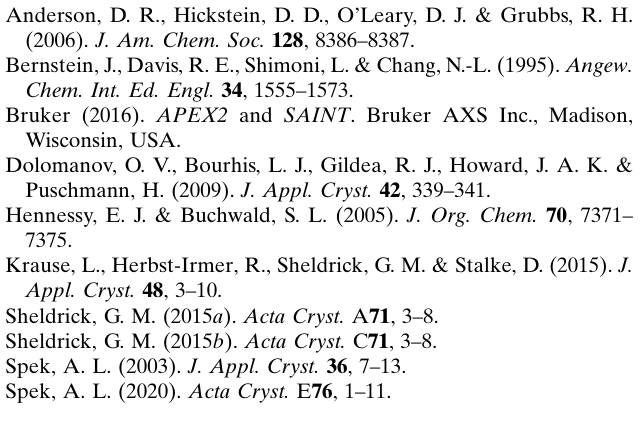
(10) graph-set notation (Bernstein et al. , 2